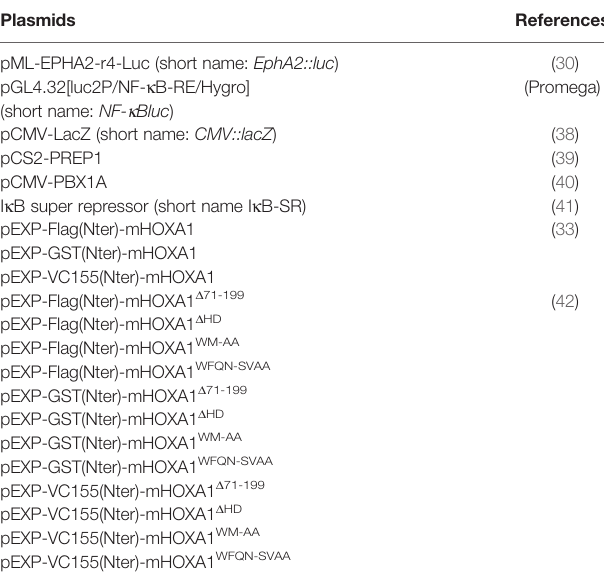
TABLE 1 | Previously described expression vectors and reporter plasmids.